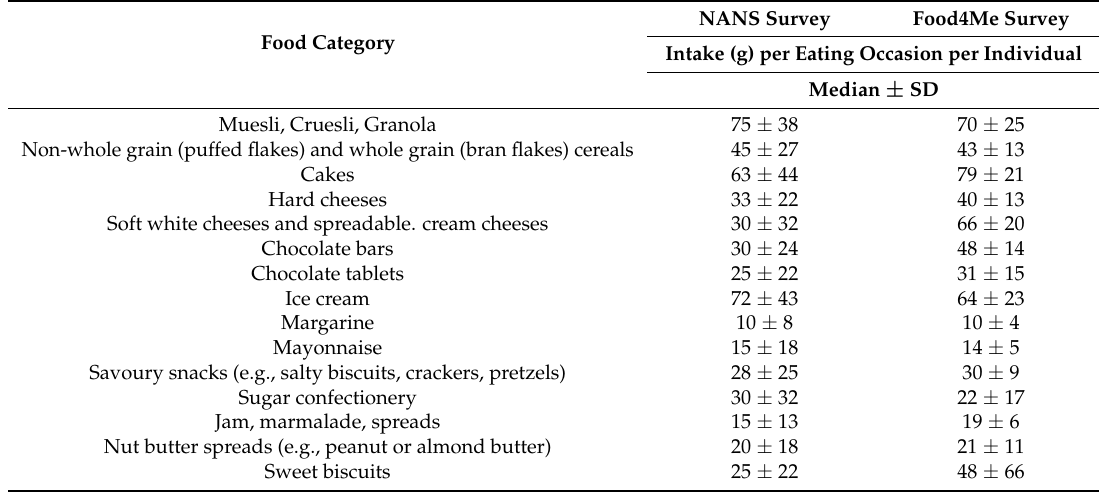
Table 2. Estimates of portion size from both the NANS and the Food4Me study.